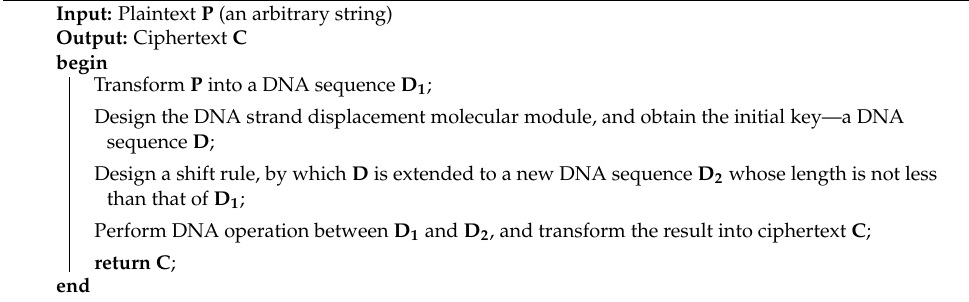
Algorithm 1: A new bio-experiment-based encryption